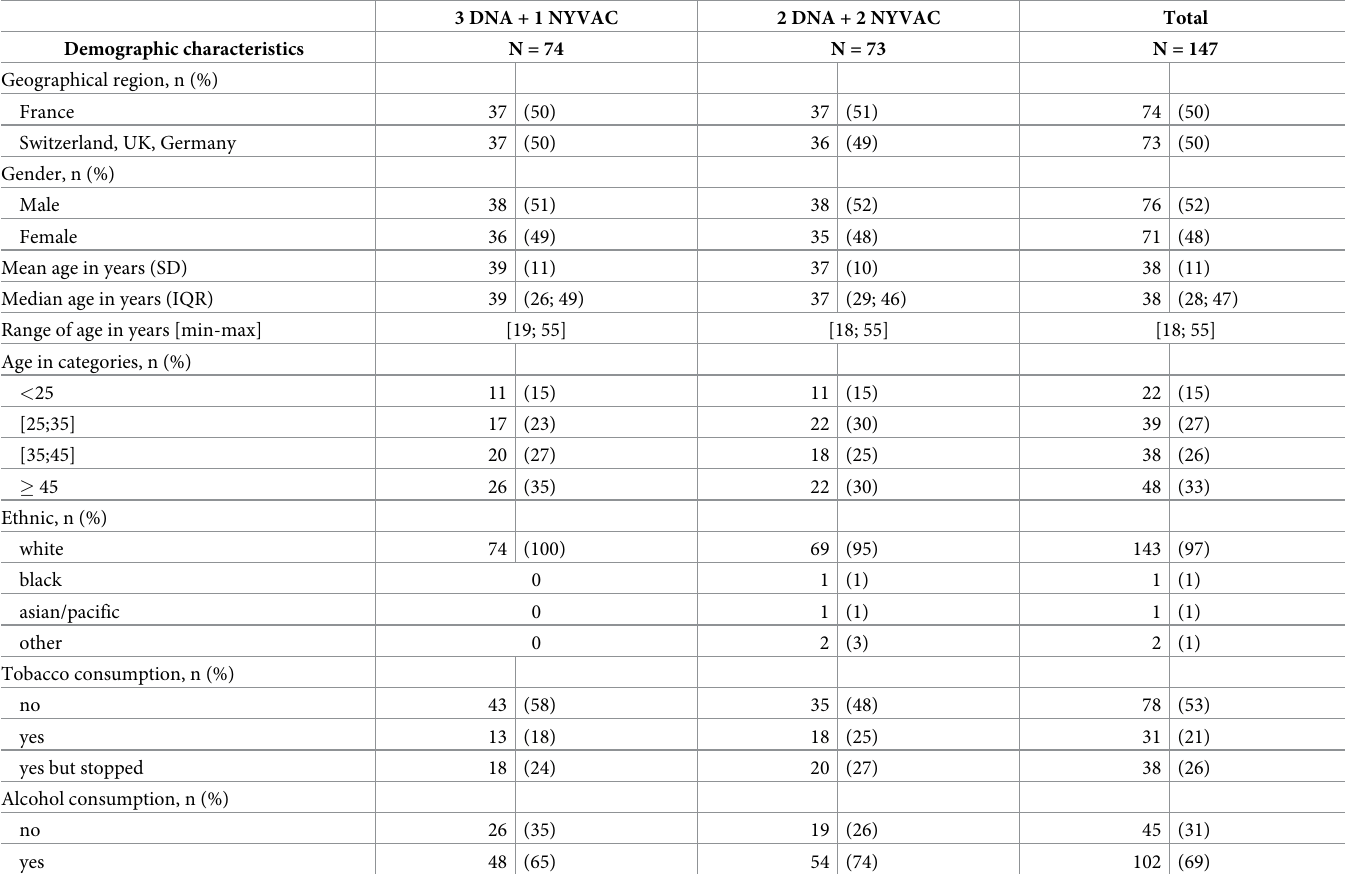
Table 1. Demographic characteristics of participants, EV03/ANRS VAC20 Phase I/II